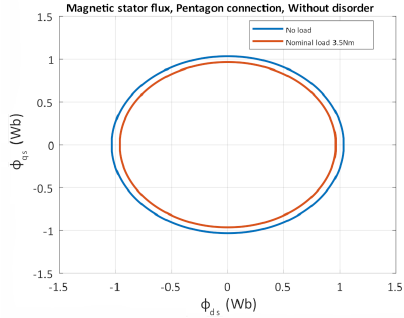
Figure 18. Magnetic stator flux, star connection, without disorder.